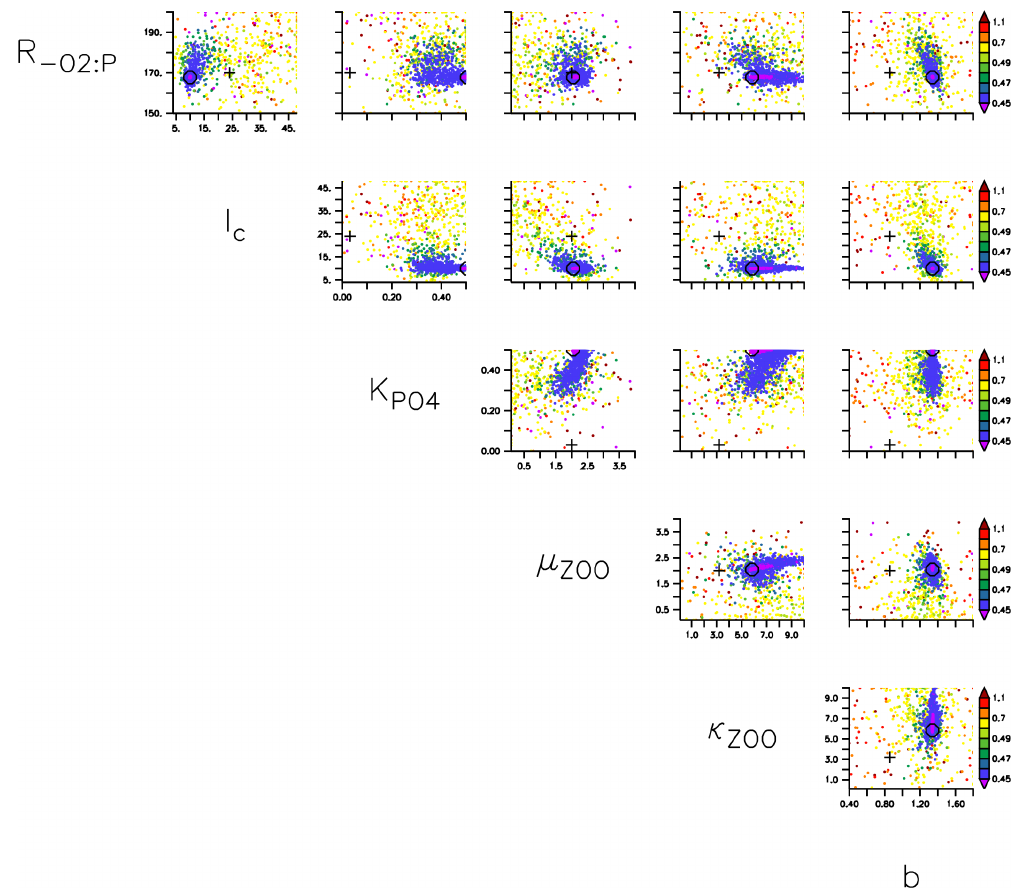
Figure 12. As Fig. 5, but for optimization OBS-WIDE-20. Note that the color scale differs from that of Fig. 5.